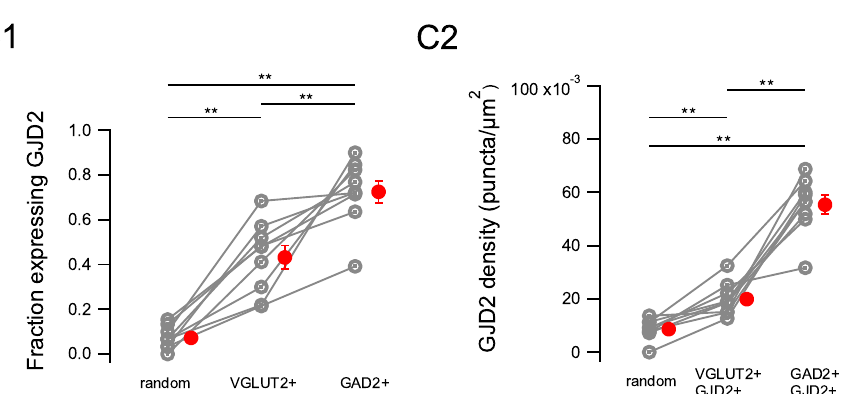
Figure 6. Expression of GJD2 mRNA in the nidopallium from canaries. GJD2 mRNA is expressed by a larger fraction of GAD2 mRNA-positive than VGLUT2 mRNA-positive neurons. ( A1 – A4 ) single confocal planes from the nidopallium. ( B1 , B2 ) magnification of representative VGLUT2 mRNA-positive and GAD2 mRNA-positive cells from regions highlighted in A4. ( C1 ) fraction of cells expressing GJD2 within each population of labeled neurons: VGLUT2 mRNA-positive and GAD2 mRNA-positive cells. ‘Random’, randomly drawn ROIs which did not include DAPI staining and which were neither stained for DAPI nor for VGLUT2/GAD2. ( C2 ) GJD2 mRNA density of GJD2 mRNA-expressing VGLUT2 and GAD2 mRNA-positive neurons. ** P < 0.01, two-tailed Wilcoxon signed-rank test. Each gray symbol represents the average for one animal. The average values of one animal for the three types of ROI are linked by a line. Red symbols, average across animals. Error bars: ±